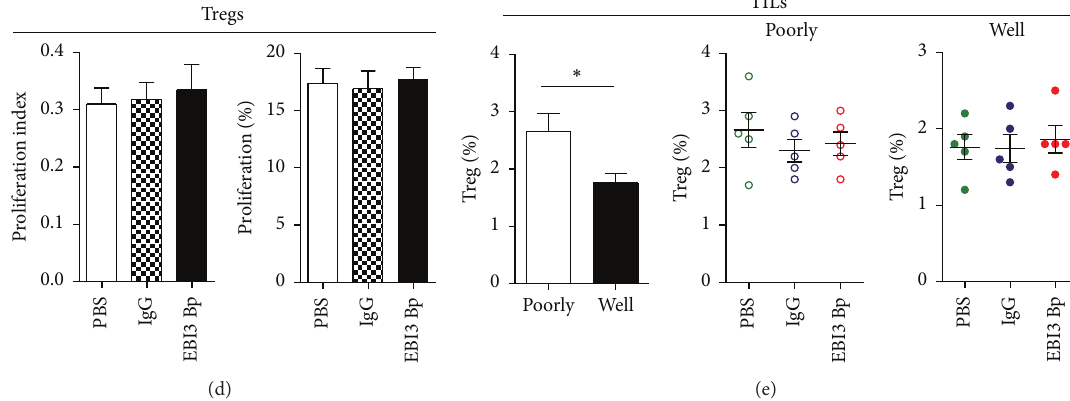
Figure 3: Assessing the role of EBI3 blocking in antitumor CTL response by flow cytometry. (a) Representative images for the Granzyme B and IFN- 𝛾 production on CD45 + CD3 + CD8 + TILs after being cocultured with CRC cells stimulated with EBI3 Bp for 3 days, an isotype IgG, and PBS for control. Scatter plot graph showing the percentage of Granzyme B and IFN- 𝛾 production on CD45 + CD3 + CD8 + TILs. (b) Representative images for EBI3, IL-27p28, and IL-12p35 expression on CD45 + CD3 + TILs after being cocultured with CRC cells stimulated with EBI3 Bp, IgG, and PBS by flow cytometry. (c) Representative images for CD45 + CD3 + CD8 + TILs cell proliferation after being cocultured with CRC cells stimulated with EBI3 Bp, IgG, and PBS were detected by CFDA assay. The value (inside) for the percentage of cells that divided at least once (top left corner) and the average number of cell divisions (bottom left corner) are indicated for each groups. (d) Treg cell proliferation after being cocultured with CRC cells stimulated with EBI3 Bp, IgG, and PBS was detected by CFDA assay. (e) Treg cell content in TILs from poorly and well differentiated tumor tissues was detected by FCM after being cocultured with CRC cells stimulated with EBI3 Bp, IgG, and PBS. ∗ 𝑃 < 0.05 ; ∗∗ 𝑃 < 0.01 ; ∗∗∗ 𝑃 < 0.001